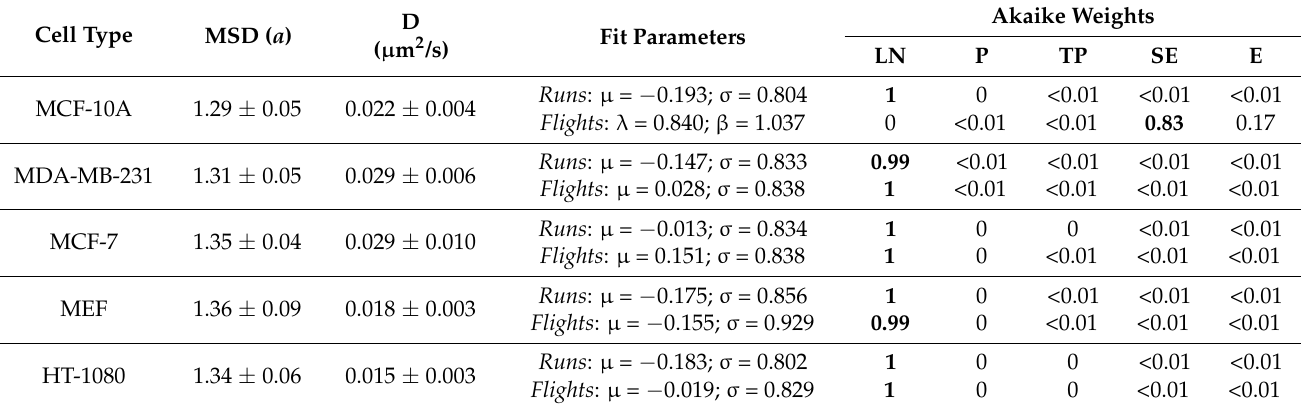
Table 1. Statistical analysis of lysosome movements in cancer and noncancerous cells. The exponent α and diffusion coefficient D values were computed from mean square displacement (MSD) versus time plots shown in Figure 2a. Data = mean ± s.d. n = 4–8 cells (see below). The fit parameters for run and flight lengths—from lognormal (or stretched exponential where appropriate) distributions—and Akaike weights for all model comparisons are shown (see Section 2 for details). LN = lognormal, P = power law, TP = truncated power law, SE = stretched exponential, E = exponential. The strongest supported model is indicated in bold. Complementary cumulative distribution functions (CCDFs) for run ( l ) and flight ( L ) lengths shown in Figure 2e–h for all cell types fit lognormal distributions, except MCF-10A for which the CCDF for L fits stretched exponential distribution. See also Figure A1 for model fits. The number of cells and lysosome trajectories analyzed were as follows: MCF-10A ( n = 8 cells, l = 5260 lysosome trajectories), MDA-MB-231 ( n = 4, l = 1076), MCF-7 ( n = 4, l =